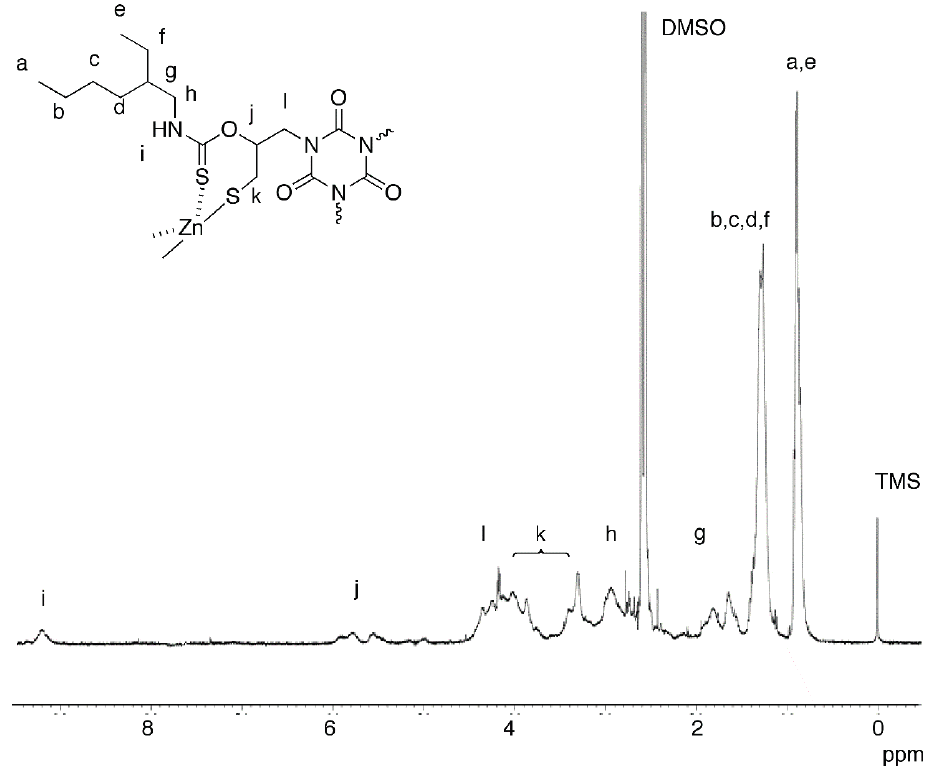
Figure 1. 1 H-NMR spectrum (400 MHz, 5:1 DMSO- d 6 /CF 3 COOH) of the polymer obtained in run 1 in Table